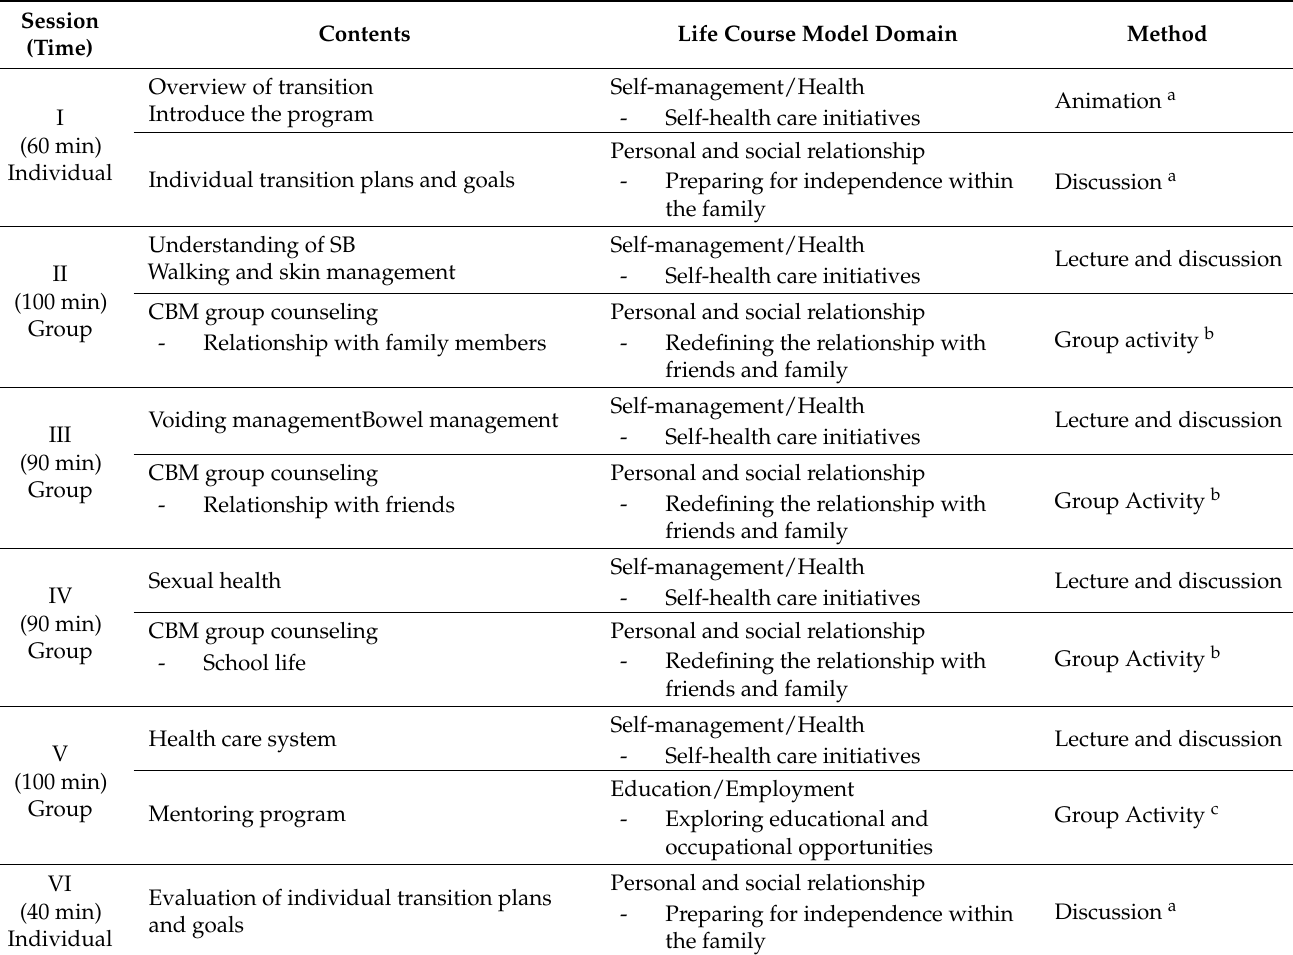
Table 2. The contents of the transition care